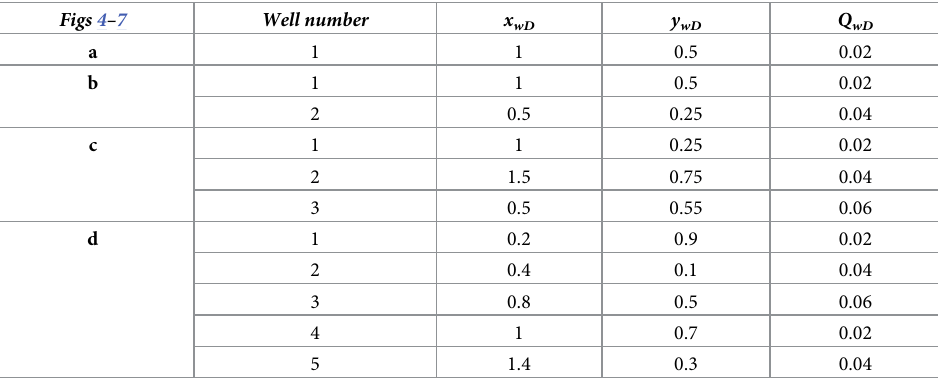
Table 2. Extraction rates and coordinates of extraction wells in Figs